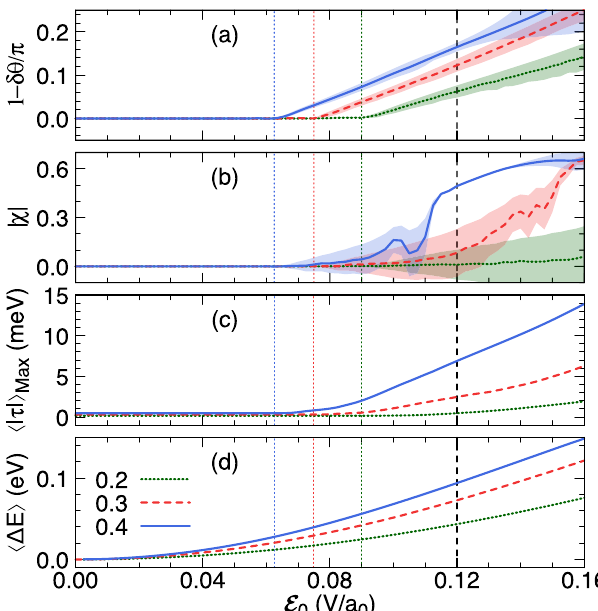
Fig. 5 Variation of different observables with respect to applied fi eld strength for different hopping parameters. Variation of ( a ) relative angle δθ , with the root mean square deviation given by shaded region; b chirality ∣ χ ∣ , with shaded region denoting the χ dev ; c maximum average torque 〈 ∣ τ ∣ 〉 〈 Δ E 〉 with respect to the Max , and ( d ) average pumped energy amplitude of the applied pulse E 0 . Green, red and blue lines represent hopping parameters 0.2, 0.3, and 0.4 eV and corresponding onset of δθ is denoted by the vertical dashed line of same colour. The values are averaged over 16 different con fi gurations at 8 ps. The vertical black dashed line corresponds electric fi eld used in Fig. 2.